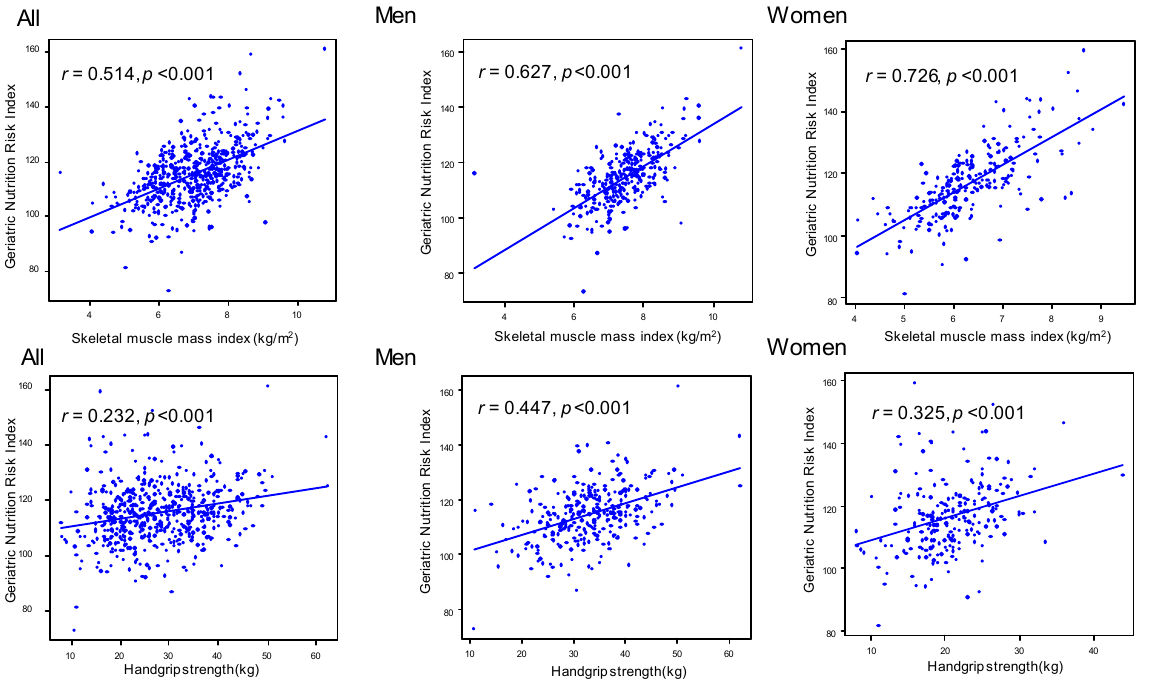
Figure 2. Correlation between geriatric nutrition risk index and skeletal muscle mass index or handgrip strength. The association between the GNRI and the presence of sarcopenia is presented in Table 3. Low GNRI was related to the prevalence of sarcopenia (adjusted OR, 4.88 [95% CI: 1.88–12.7], p = 0.001). Table 3. Odds ratio of low geriatric nutritional risk index on the presence of